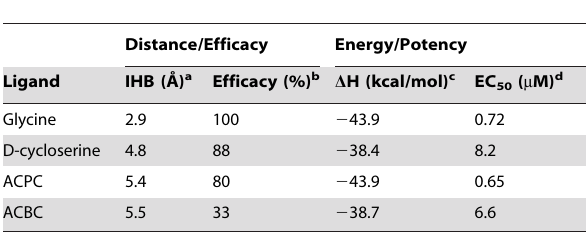
Figure 4. Closure mechanism of GluN1-LBD and connection to transmembrane domain. (A) Model showing the hypothesized conformational changes taking place at LBD and TM domain in binding of either an agonist or antagonist to cleft between D1 and D2. Agonist and antagonist bound models are colored green and red, respectively. Colored arrows depict the hypothesized forces affecting the conformation of the domains (full agonist in green, partial agonist in yellow and antagonist in red). (B) Distance measurements of Gly458 N -Gln686 O and Gln405 OE1 - Trp731 NE1 from D-cycloserine bound open-cleft GluN1-LBD taken from a constraint-free MD simulation trajectory. Comparison of the two distances reveals that there is a difference in the swiftness of closure of the LBD at various sides of the binding cleft. In addition, the intermediate closure is not seen ubiquitously at the binding cavity. In (C), superimposed structures are taken from the trajectory of the simulation in (B). The starting structure, cycloleucine-bound open-cleft GluN1 (PDB: 1Y1M), is colored red. Snapshots from intermediately closed (yellow) and fully closed (green) LBD are taken at time steps of 13 and 19 ns, respectively. In (D), part of an iGluR monomer (from GluA2 structure, PDB: 3KG2) show that the IHB is directly linked to M3. The purple ball represents the location of Gly458, which is the IHB-residue at D2 side of GluN1-LBD. Locations of Trp731 and Ala715 are depicted as orange and pink balls, respectively. doi:10.1371/journal.pone.0047604.g004 (Figs. 3C and S2). The average IHB distances from SMD simulations were calculated for all the partial agonists studied at the intermediate closure stage. With bound D-cycloserine, GluN1- LBD settles to an average of 4.8 6 0.5 A˚ distance when Table 1. Average IHB distance and D H from SMD simulations ACBC are 5.4 6 0.2 and 5.5 6 0.2 A˚ , respectively. It is difficult to compared to experimentally obtained efficacies and EC 50 values for various GluN1